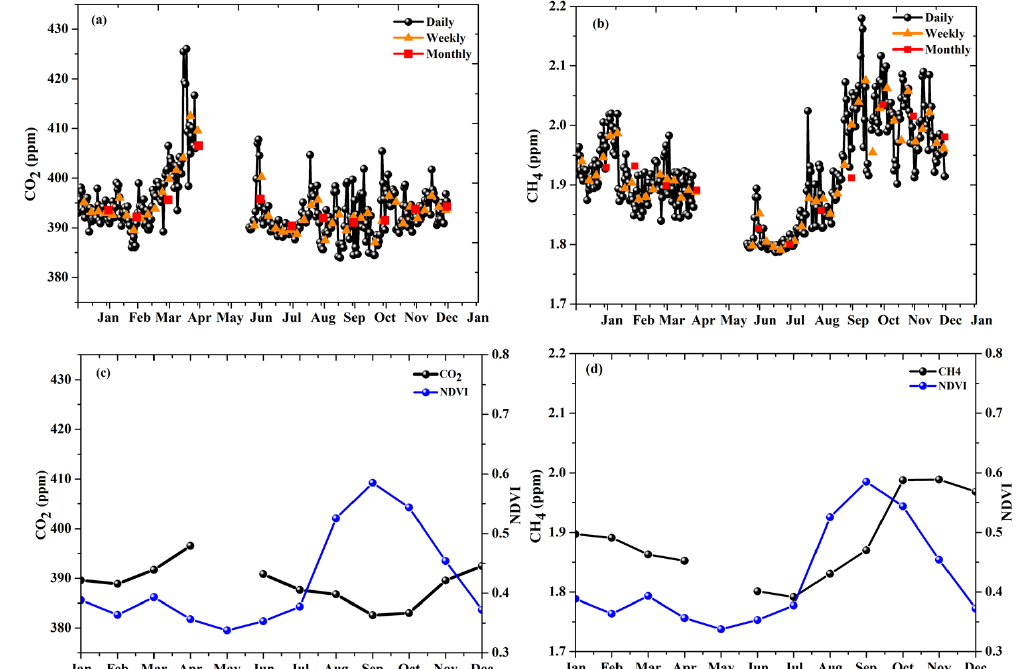
Figure 2. (a–b) Temporal variations of CO 2 and CH 4 ; (c–d) seasonal variations of CO 2 and CH 4 in conjunction with NDVI (Normalized Difference Vegetation Index) during 2014.